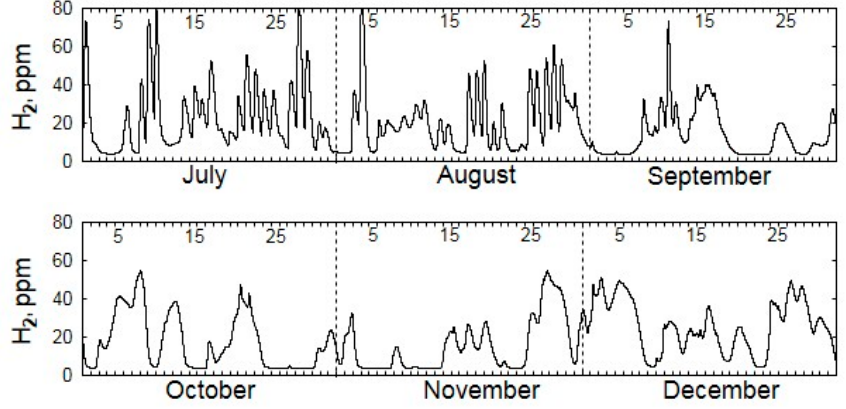
Figure 9. Variations in relative hydrogen concentrations in the Karnasurt underground mine (Lovozero loparite deposit) reflecting the FG emission dynamics (fragments of a long time-series [76]).